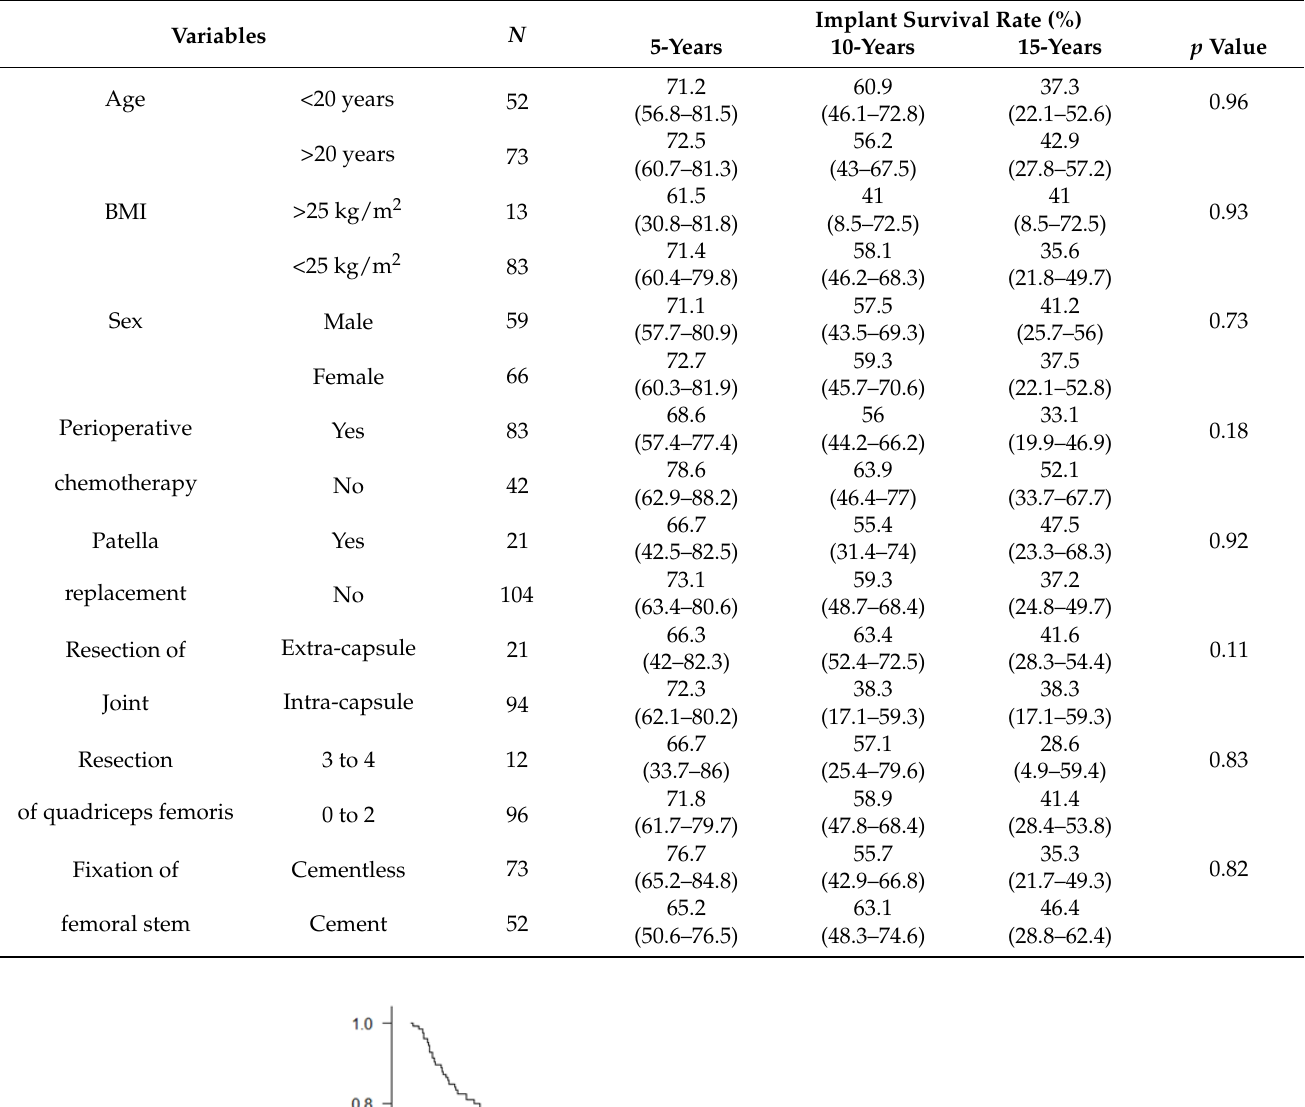
Table 3. The relationship between implant survival and patient characteristics.